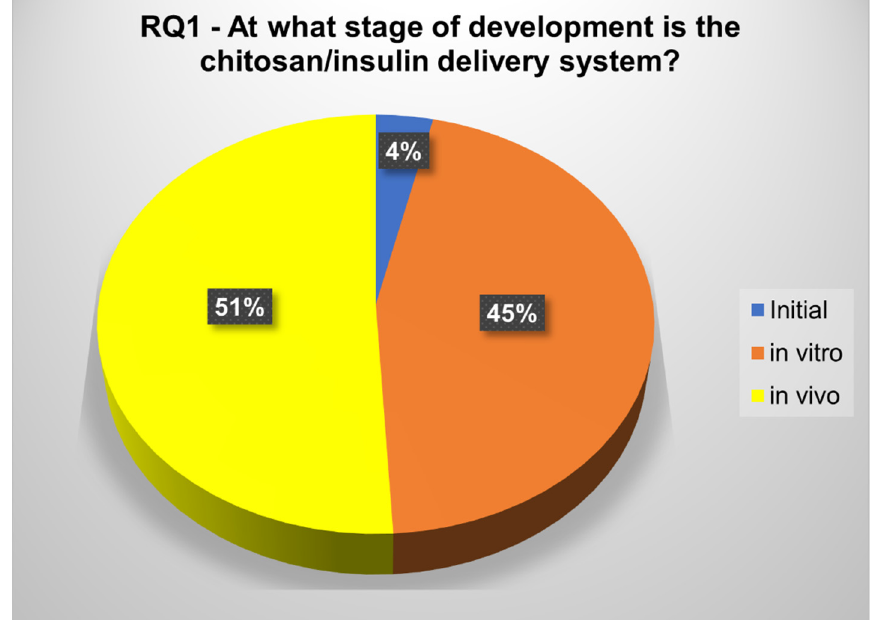
Figure 8. Development stage of the studies according to RQ1.